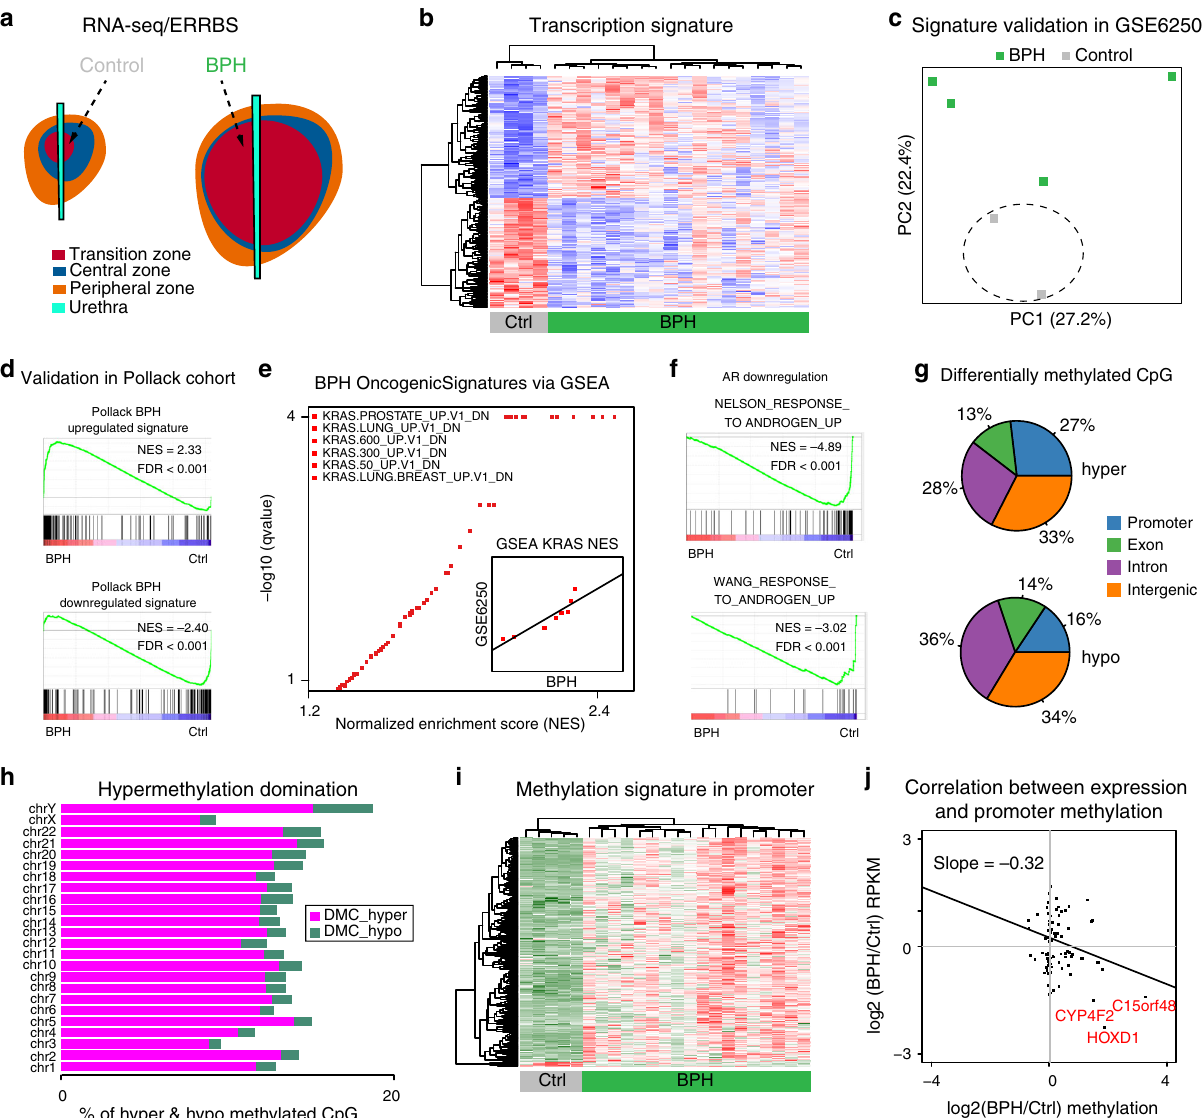
Fig. 2 BPH transcription and methylation pro fi les. a Diagram of sampling location of BPH and control samples used for RNA-seq and ERRBS. Green color represents BPH samples, and gray color represents control samples from normal transition zones of men undergoing radical prostatectomy for prostate cancer (without clear evidence of BPH). b Hierarchical clustering and heatmap of transcriptional signatures based on signi fi cantly differentially expressed genes between BPH and control samples. c Validation of transcriptional signature (panel B) in an independent study (GSE6250). Green color represents BPH samples, and gray color represents control samples from normal transition zones of men undergoing radical prostatectomy for prostate cancer (without clear evidence of BPH). d The concordance of transcriptional signatures between current and previous BPH study. GSEA analyses of current BPH cases showing that genes upregulated in previous BPH cases are positively enriched, and genes downregulated in previous BPH cases are negatively enriched. e GSEA analysis of BPH cases in oncogenic signatures showing that genes downregulated in many cell lines when over-expressing an oncogenic form of KRAS gene are positively enriched. Similar results and high correlation with GSE6250 study are shown in inner panel. f GSEA analysis of BPH cases in AR related signatures showing that genes upregulated in LNCaP cells treated with synthetic androgen are negatively enriched. g Pie chart of differentially methylated CpGs between BPH and control samples among different genomic regions. Colors denote different genomic related regions. h Hypermethylation domination found in each chromosome. The x -axis represents the percentages of hypermethylated (label as pink) and hypomethylated (label as green) CpGs. i Hierarchical clustering and heatmap of promoter methylation signature between BPH and control samples. j Correlation between transcription and promoter methylation signatures, examples of epigenetically silenced genes shown in